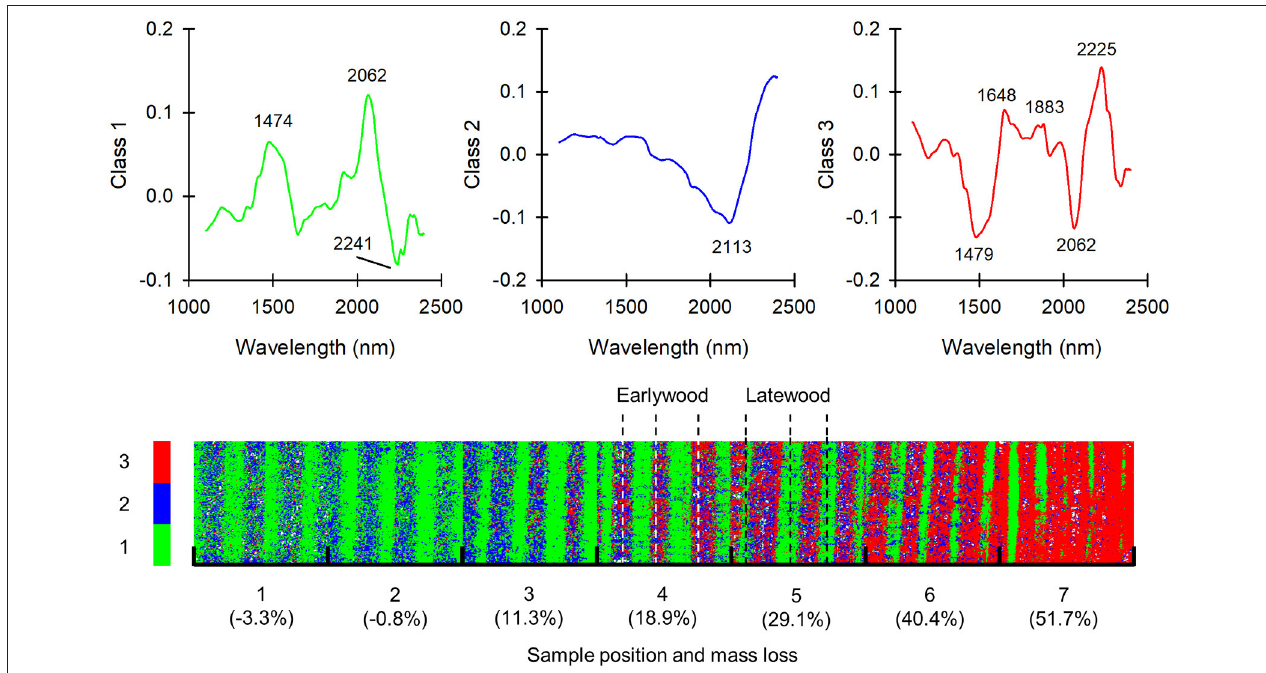
FIGURE 5 | Mean-centered spectra of classes 1–3 and the class assignments of image pixels in a set of samples exposed to C. puteana. Each individual image in the mosaic is sized 7.3 ×